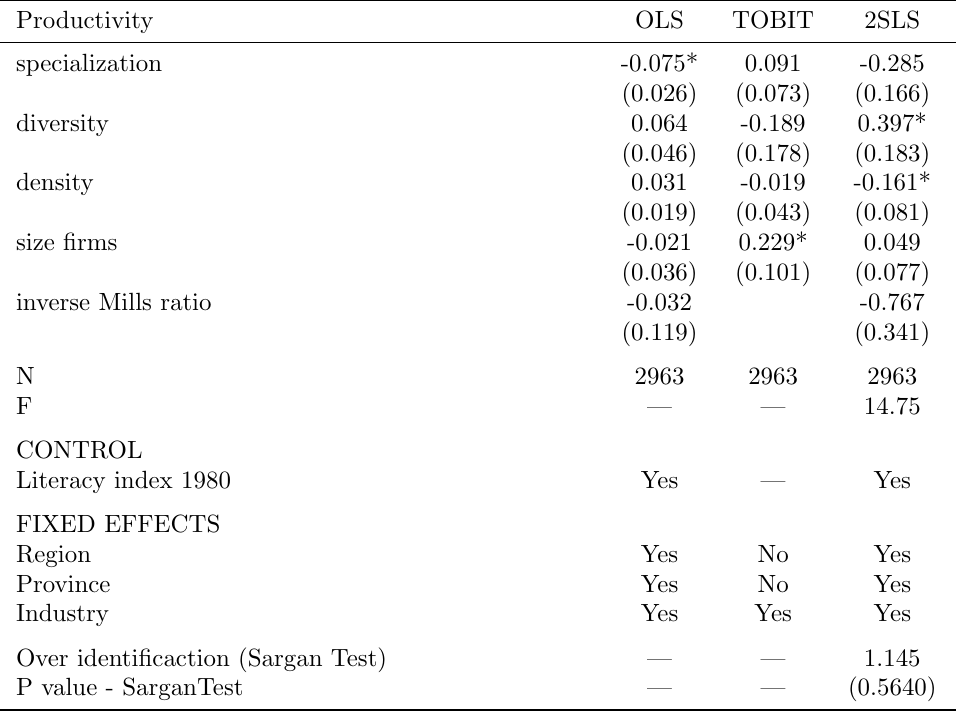
Table 2: Productivity growth: Estimates by OLS, Tobit and IV